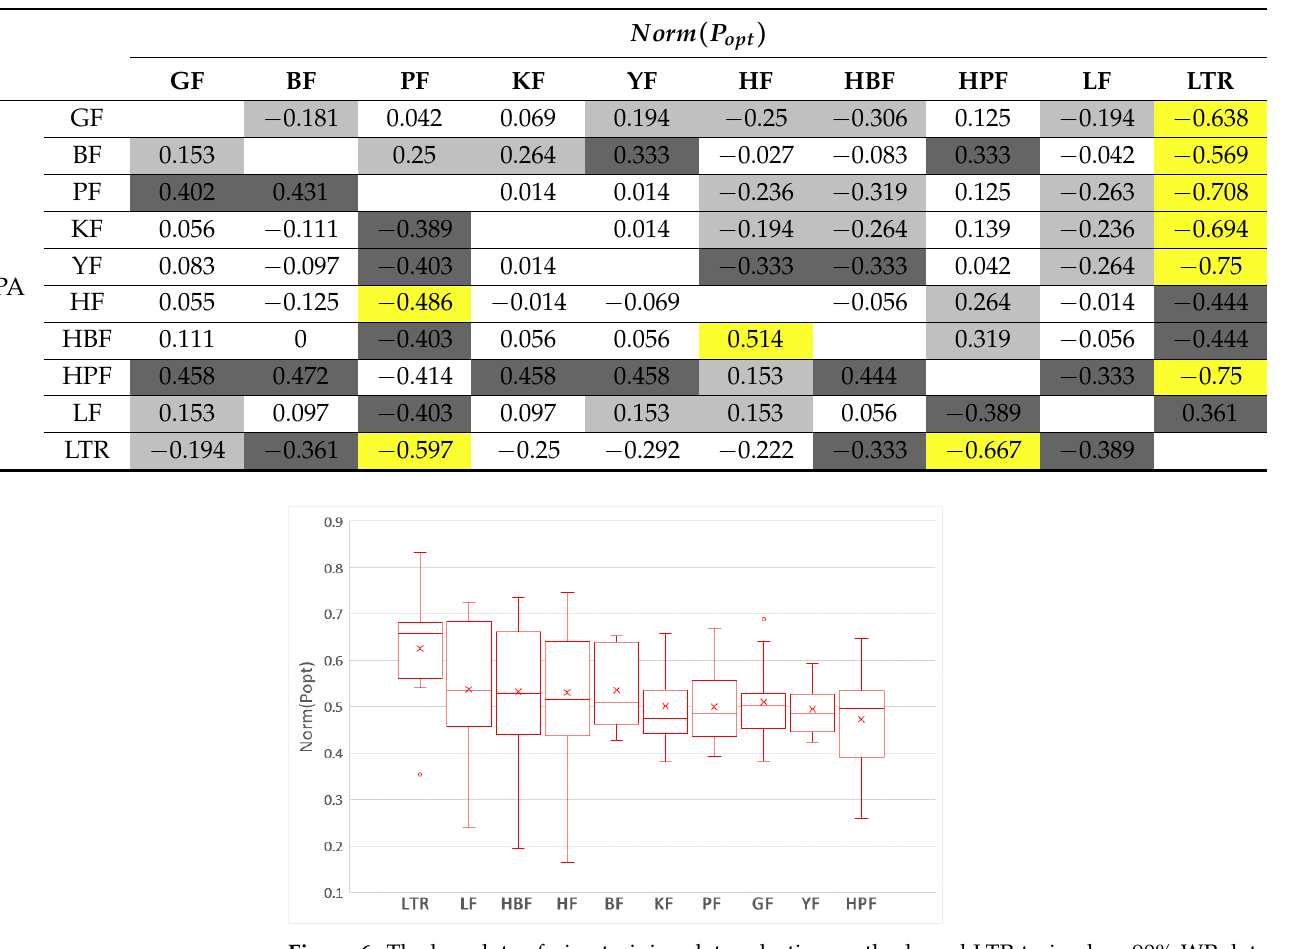
Figure 6. The boxplots of nine training data selection methods and LTR trained on 90% WP data with the Scott–Knott test results in terms of